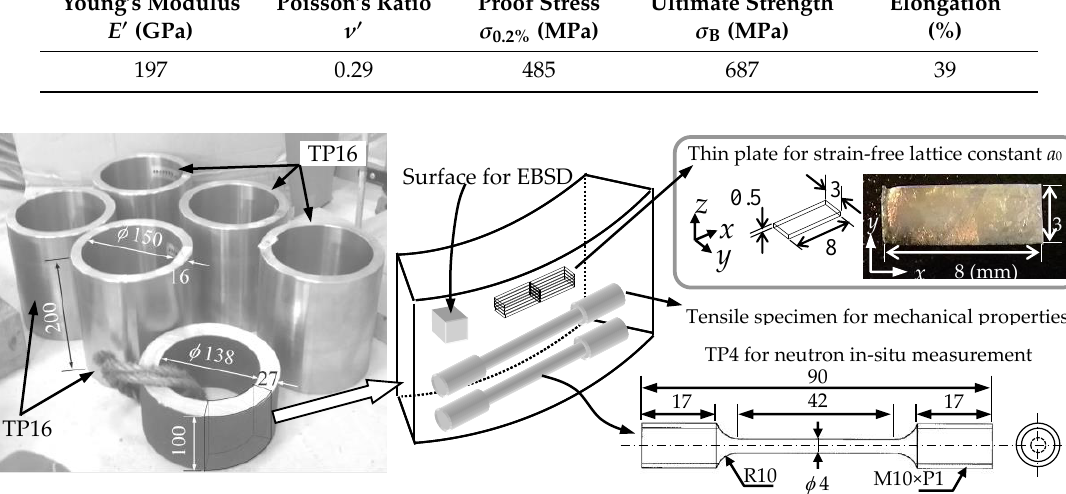
Figure 1. Schematics of specimens (unit: mm) [14].